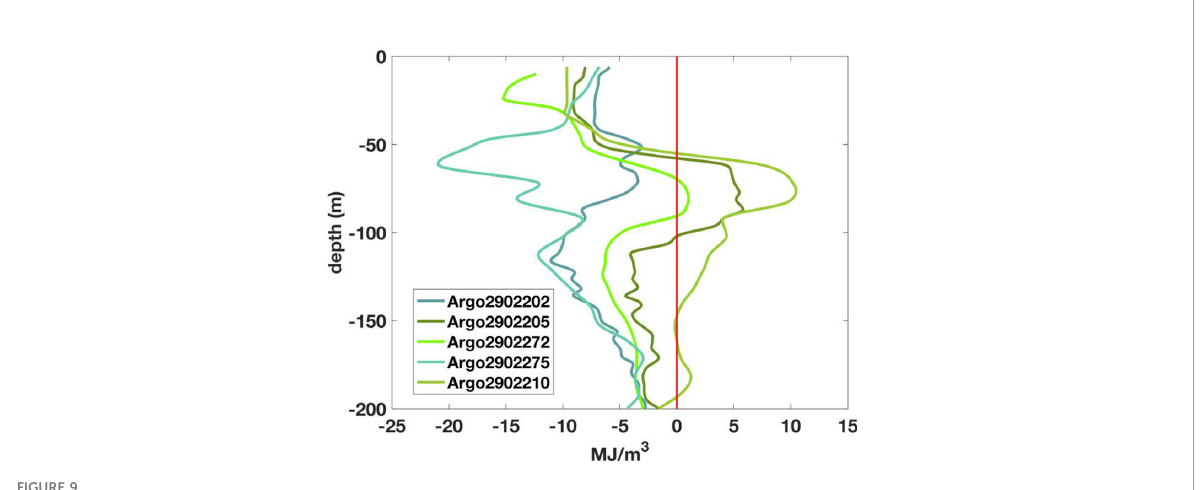
FIGURE 9 Vertical pro fi les of the heat content anomaly according to each Argo fl oat.